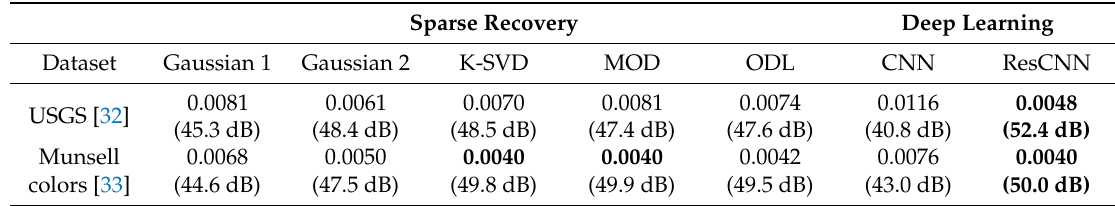
Table 4. Average RMSEs and PSNRs for the measured datasets.